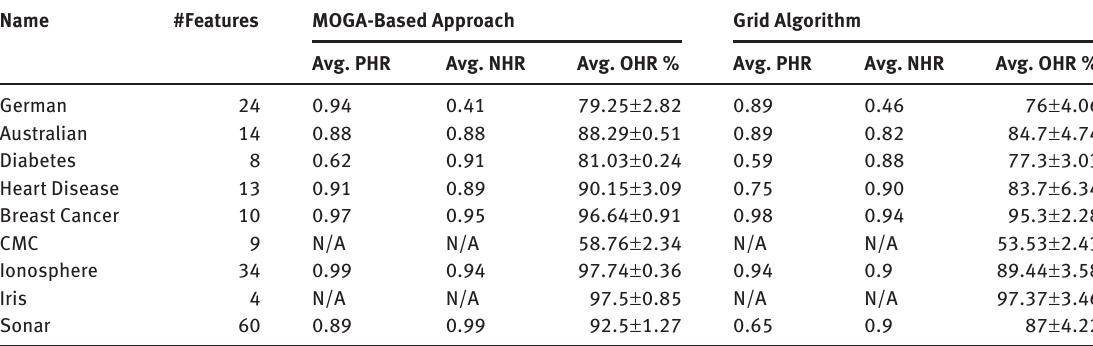
Table 7. Comparison of the Proposed Approach with the Grid